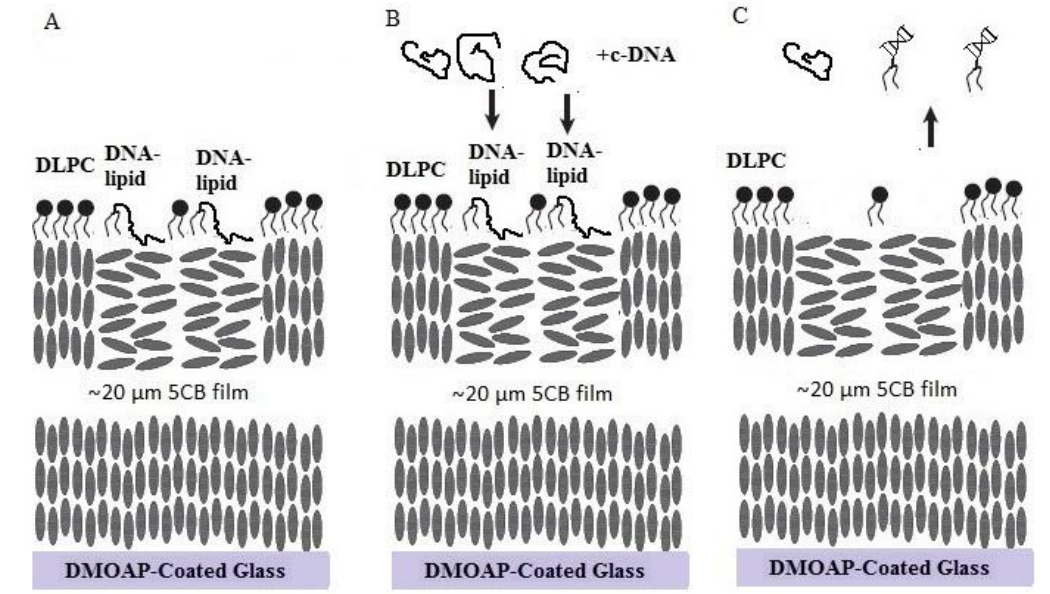
Figure 5. The schematic illustration of the LC-aqueous interface decorated with DNA-lipids and L - DLPC, ( A ) before and ( B ) after addition of its complementary DNA strands, c-DNA. ( C ) DNA-lipids hybridize with c-DNA to form double strands and disassemble from the LC-aqueous interface.